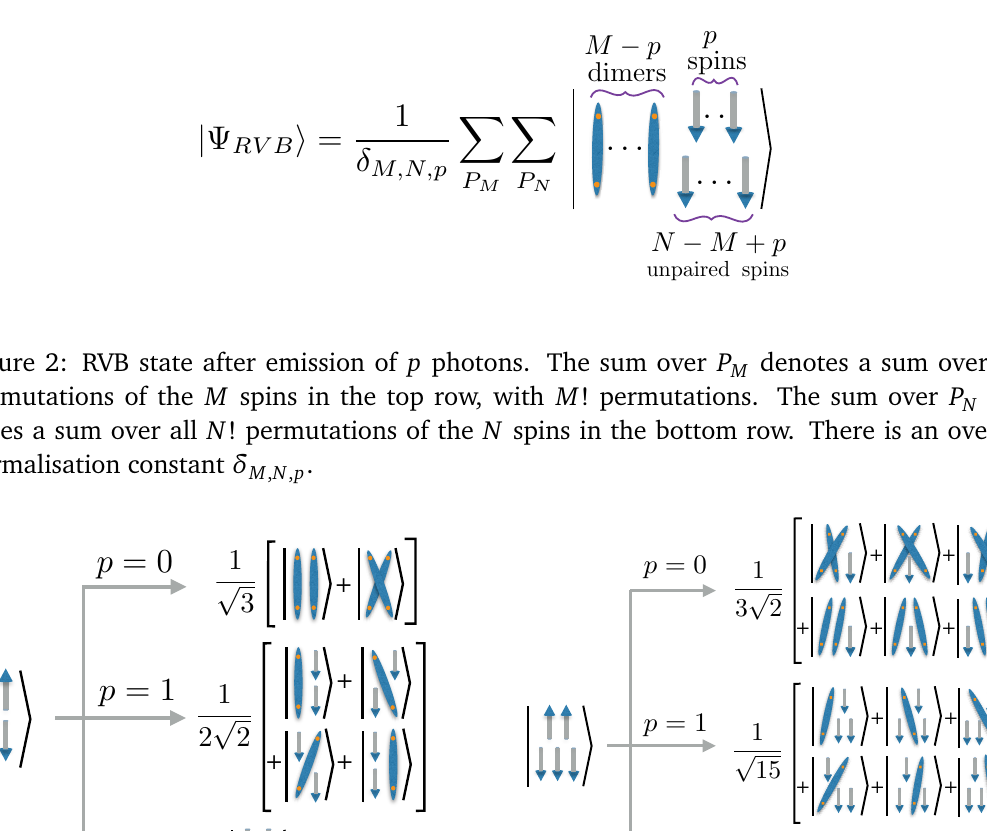
Figure 3: RVB states arising from photon measurement. Left: For the initial state with M = 2 and N = 2, possible outcomes for number of photons emitted are p = 0,1,2. Each outcome collapses the spin wavefunction into an RVB state which contains 0, 2 and 4 unpaired spins respectively. Right: For the initial state with M = 2 and N = 3, possible outcomes for photon emission are p = 0,1,2. The collapsed RVB states contain 1, 3 and 5 unpaired spins respec-